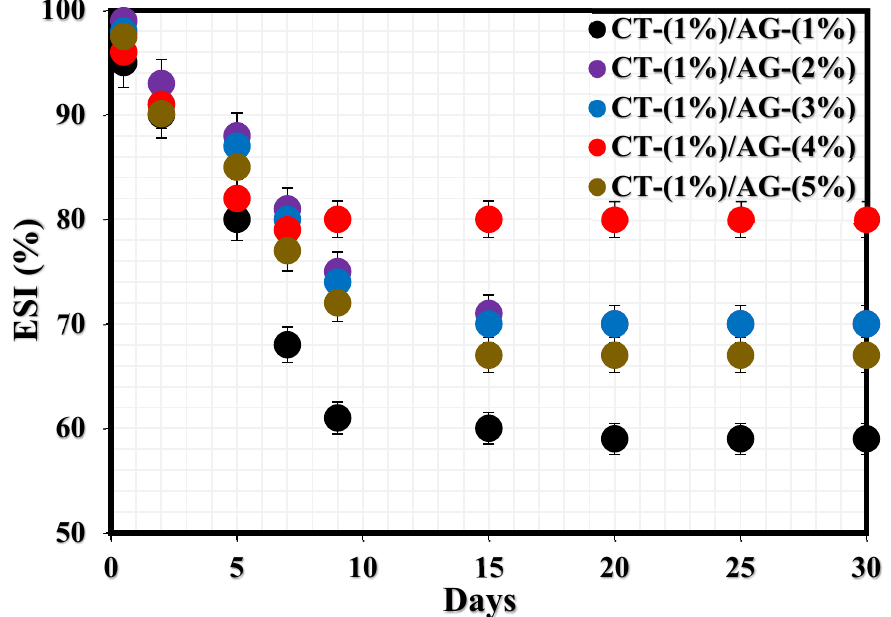
Figure 1. Stability tests of emulsions stabilized by various CT/AG blends.